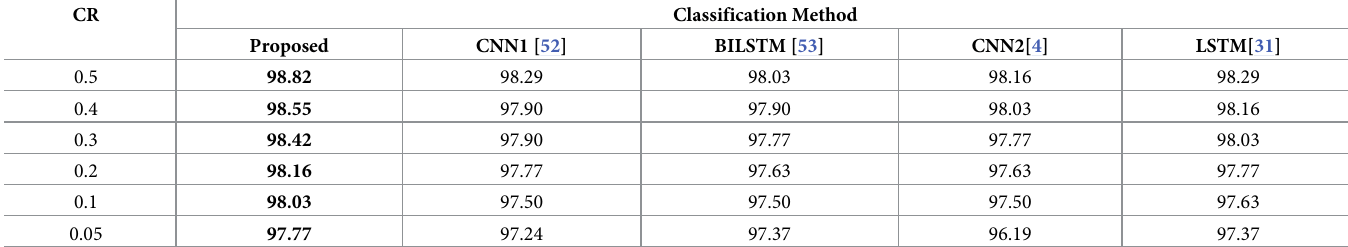
Table 5. Accuracy of different classification methods in the MIT-BIH arrhythmia database test set at different compression ratios. CR